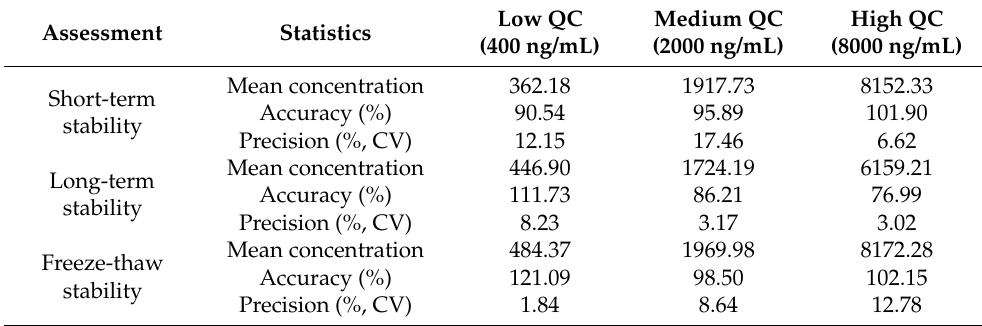
Table 2. The stability assessment of MAC glucuronide phenol linked SN-38 in mouse plasma ( n =